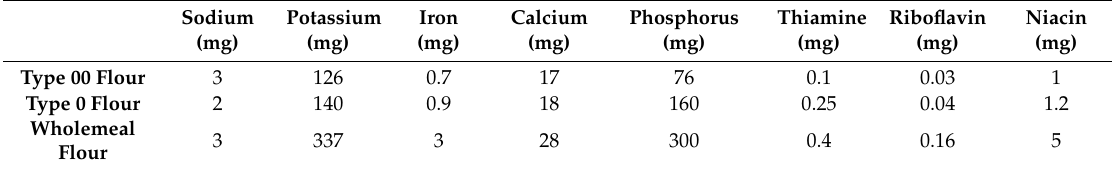
Table 5. Micronutrients (as ions) present in 100 g of some kind of frumento flour (INRAN-Istituto